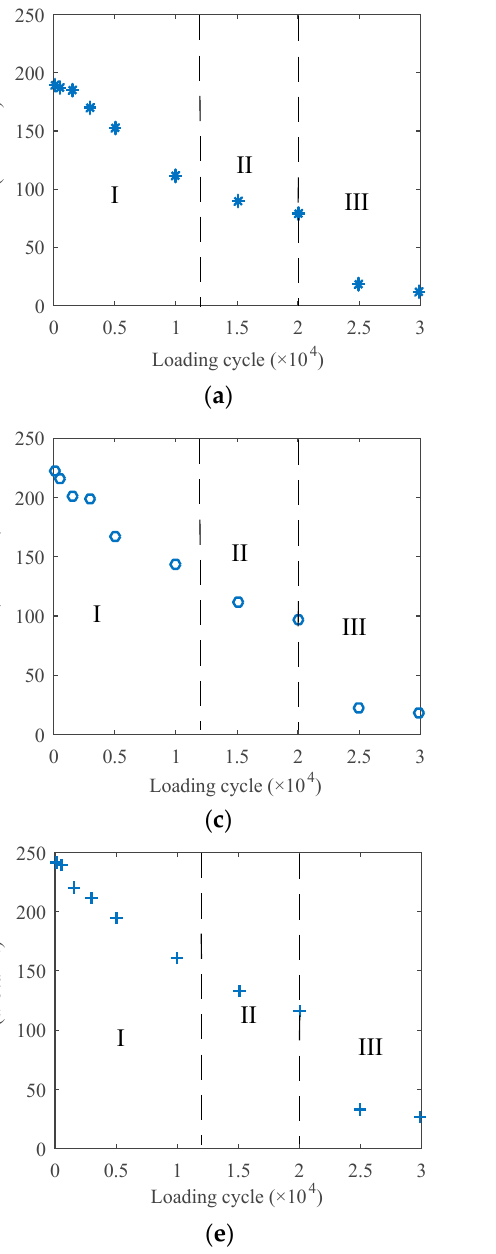
Figure 11. Amplitude variation of ( a ) the fundamental wave A 1 , ( b ) the high order harmonics A n (excitation voltage 150 V), ( c ) the fundamental wave A 1 , ( d ) the high order harmonics A n (excitation voltage 175 V), ( e ) the fundamental wave A 1 , and ( f ) the high order harmonics A n (excitation voltage 200 V) during the whole fatigue process.